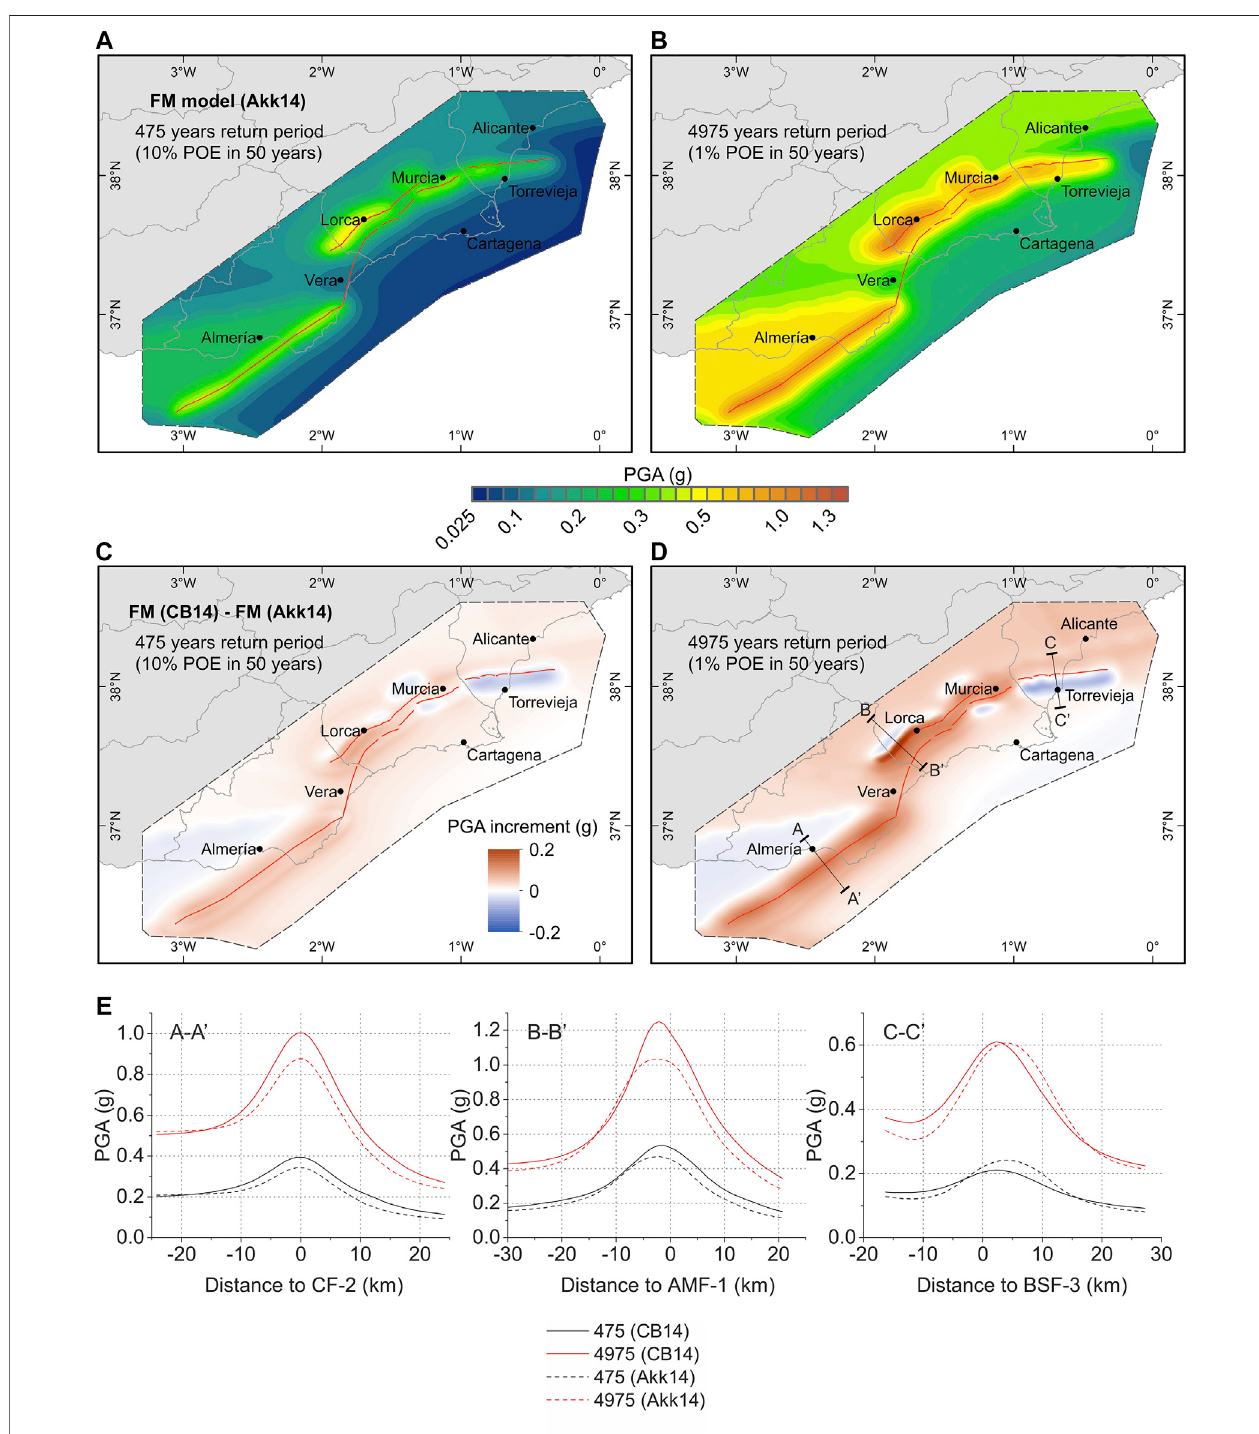
FIGURE 12 | (A) Mean hazard maps for PGA (g) of the FM model using the Akk14 GMPE (Akkar et al., 2014) for the return periods of 475 years and; (B) 4,975 years.Thecolorscaleiscommonforbothreturnperiods; (C) Difference(ing)ofthemeanhazardmapsfromtheFMmodelusingtheCB14equationwithrespecttousing Akk14forthereturnperiodsof475 yearsand; (D) 4,975 years.Thecolorscaleiscommonforbothreturnperiods.ThetracesoftheEBSZfaultsconsideredaredepicted in red in all panels; (E) Cross sections representing PGA (g) values of the FM model using the CB14 (solid line) and Akk14 (dashed line) GMPEs as a function of distance to the surface fault trace and for the same return periods as the maps. The locations of the cross sections are indicated in Figure 12D .